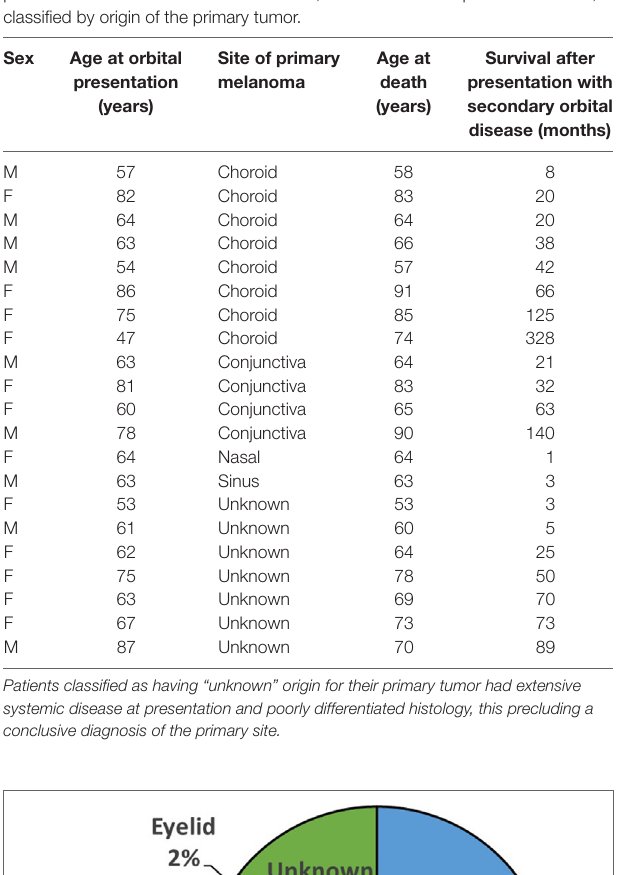
TaBle 2 | Survival after presentation with secondary orbital melanoma in 21 patients for whom date of death is known, without other complete clinical data; classified by origin of the primary tumor.